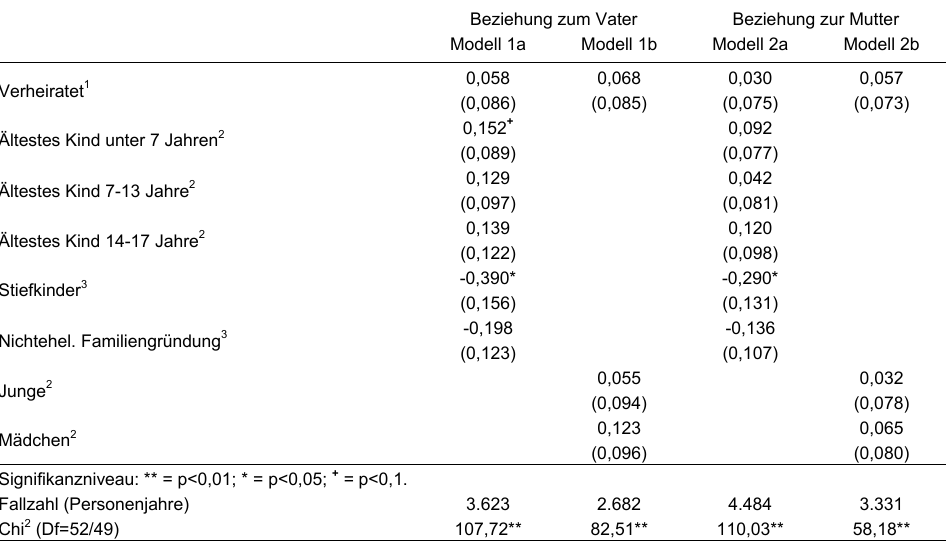
Tabelle 3: Determinanten der Beziehungsenge zu den eigenen Eltern (Ordered Random Effects Regression, Standardfehler in